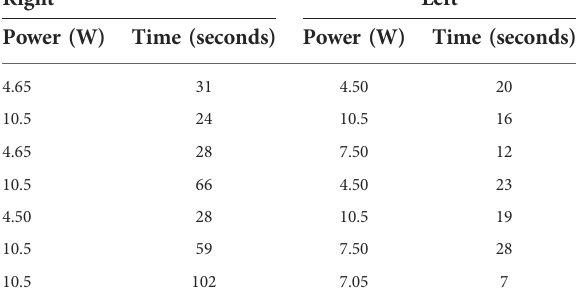
TABLE 1 MRgLITT anterior cingulotomy ablation